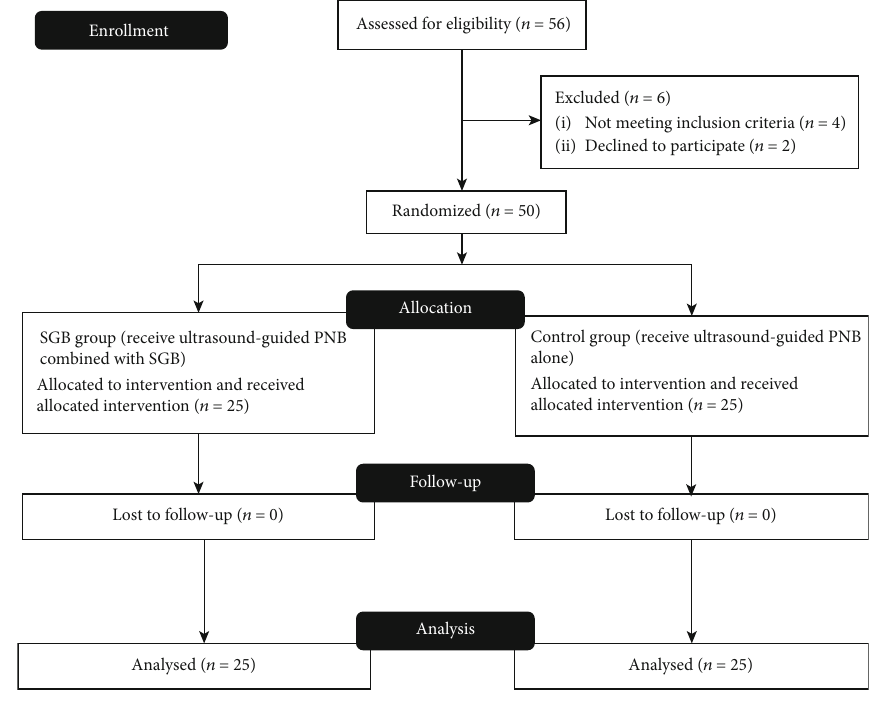
Figure 1: Consort e- fl owchart. Table 1: Baseline characteristics.